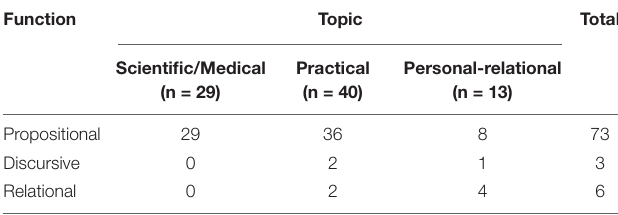
TABLE 5 | Frequency of interactional aspects of the “non lo so” ( n = 82). Interactional aspects “Non lo so” raised by the patient (responsive turn)